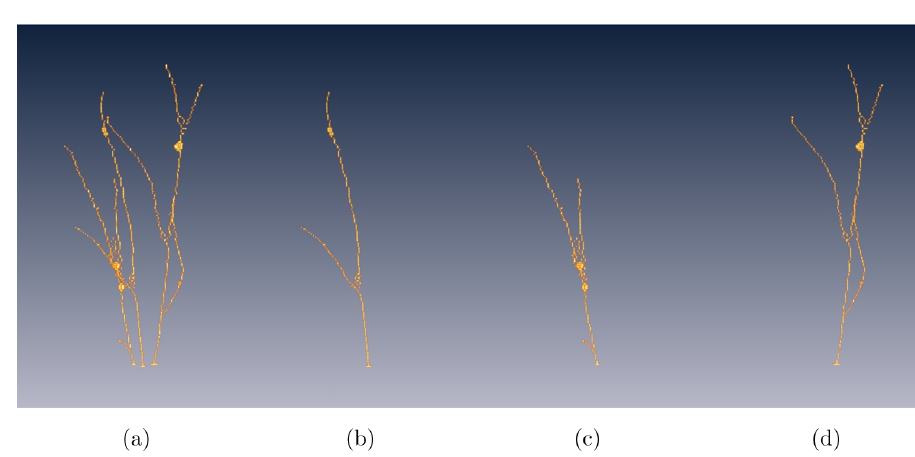
Fig. 4. Model skeletonization results (a) for a whole plant and (b), (c) and (d) for each tiller of the